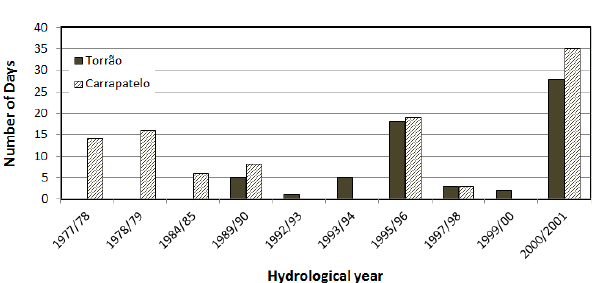
Fig. 9. Number of days with daily average flow discharged by the Figure 9. Number of days with daily average flow discharged by the Carrapatelo and Torrão 2 Carrapatelo and Torr˜ao dams greater or equal to 3000m 3 s − 1 and dams greater or equal to 3000 m 3 /s and 500 m 3 /s, respectively. All hydrological years since 3 500m 3 s − 1 , respectively. All hydrological years since the entry into the entry into operation of the dam were considered. 4 operation of the dam were